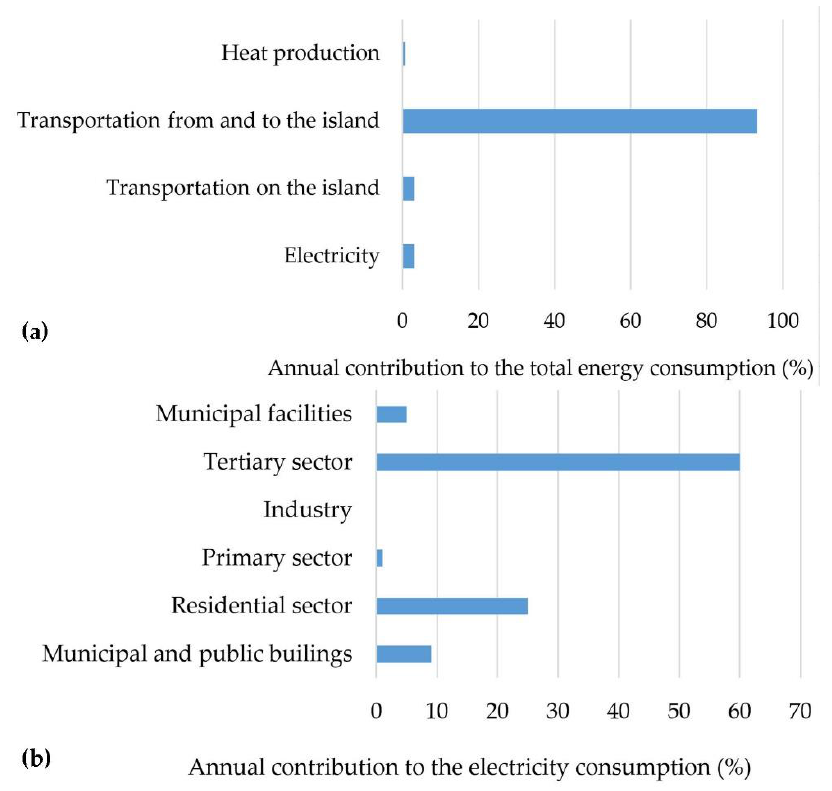
Figure 3. Annual contribution of final energy uses to the total energy consumption on Sifnos ( a ) and annual contribution of different sectors to the electricity consumption in the island ( b ).